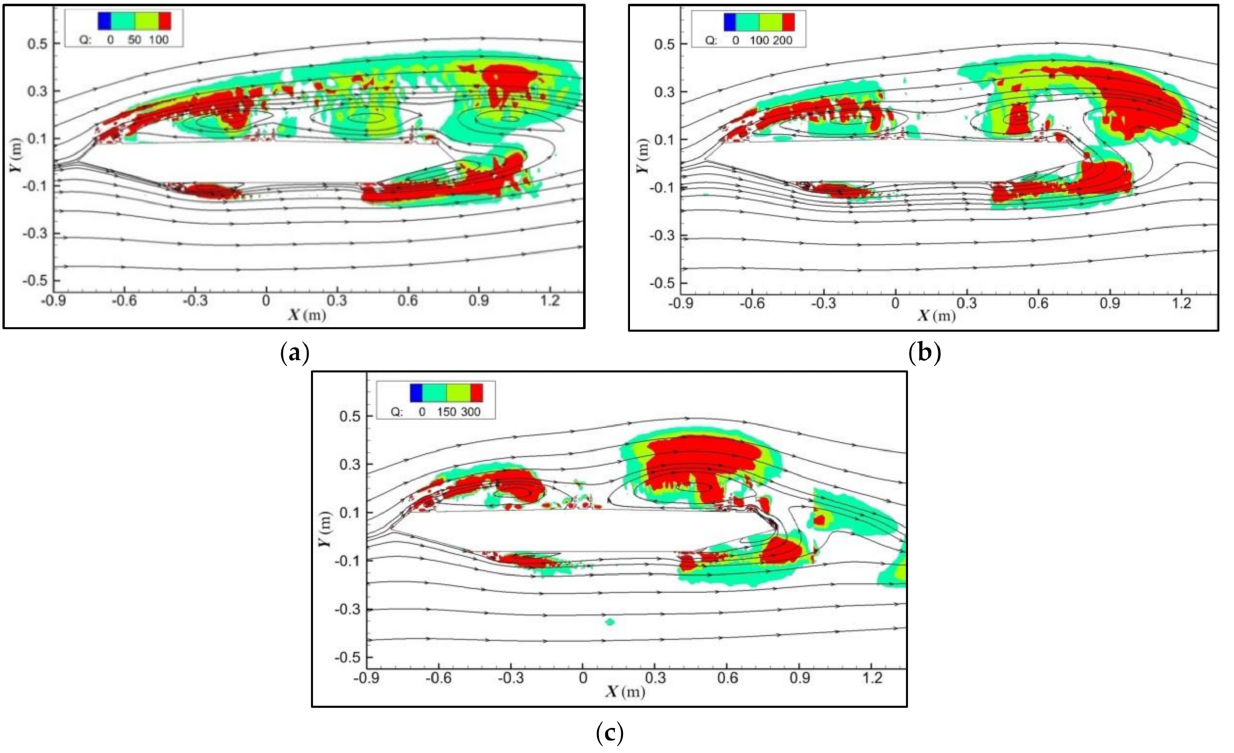
Figure 6. Contours of time-averaged vortex structures at π /2 moment (Unit: s − 1 ). ( a ) Rapid development stage of VIV. ( b ) Gradual convergence stage of VIV. ( c ) Stable vibration stage of VIV. At 0 moment, the vortex distribution at different stages of VIV is shown in Figure